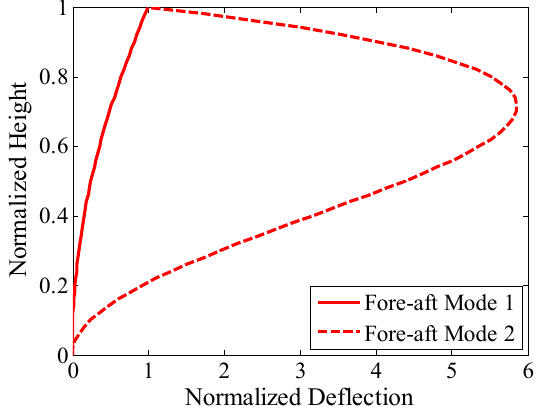
Figure 11. The tower fore-aft mode shapes.